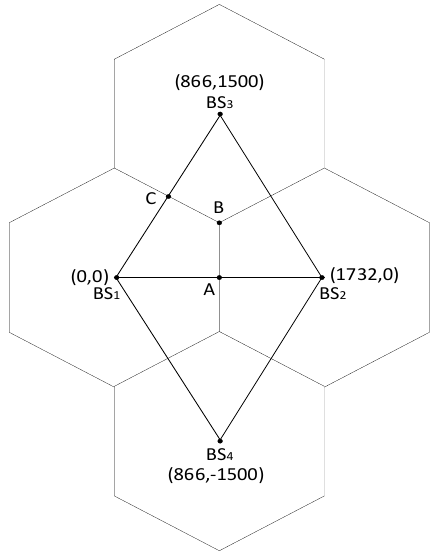
Figure 2. The considered cellular system with the four BSs